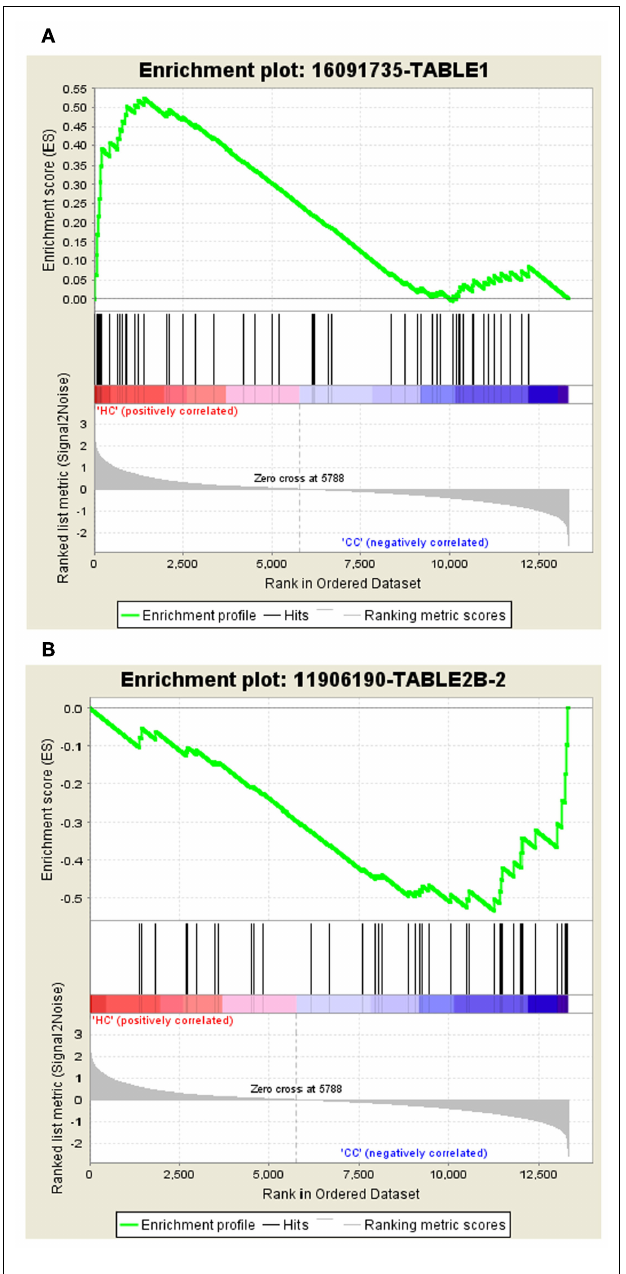
FIGURE 2 | Profile of the running ES score and positions of GeneSigDB gene set members on the rank ordered list. (A) Enrichment plot for the gene signature – 16091735-TABLE1, (B) Enrichment plot for the gene set – 11906190-TABLE2B-2.